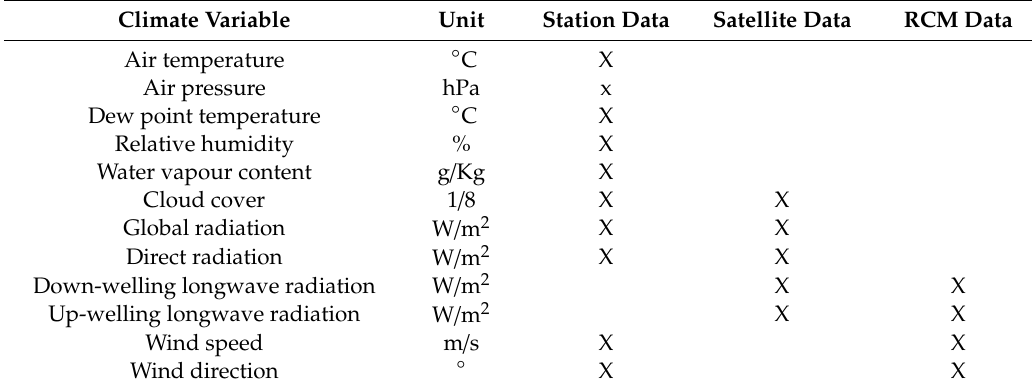
Table 1. Meteorological variables and data sources used for the gridding procedure of basis dataset of TRY [25]. RCM, Regional Climate